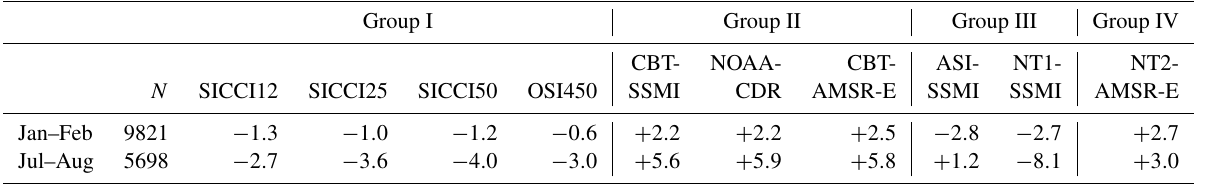
Figure 3. (a–d) Maps of the difference between the multi-annual average monthly SIC of the individual algorithms representing groups I to IV and the 10-algorithm ensemble median multi-annual average monthly SIC (e) for the Arctic for July 2003–2011 (see also Fig. S4, Supplement). Differences are only computed for sea-ice concentration of both data sets larger than 15%. Roman numbers in bold font denote the group (see Table 1) to which the algorithm is assigned. Table 2. Overall mean difference: individual algorithm SIC minus ensemble mean SIC in percent ice concentration for the Arctic for winter (months January and February) and summer (months July (see Fig. 3) and August). N denotes the total number of valid data pairs with SIC > 15.0% (see also Kern et al.,